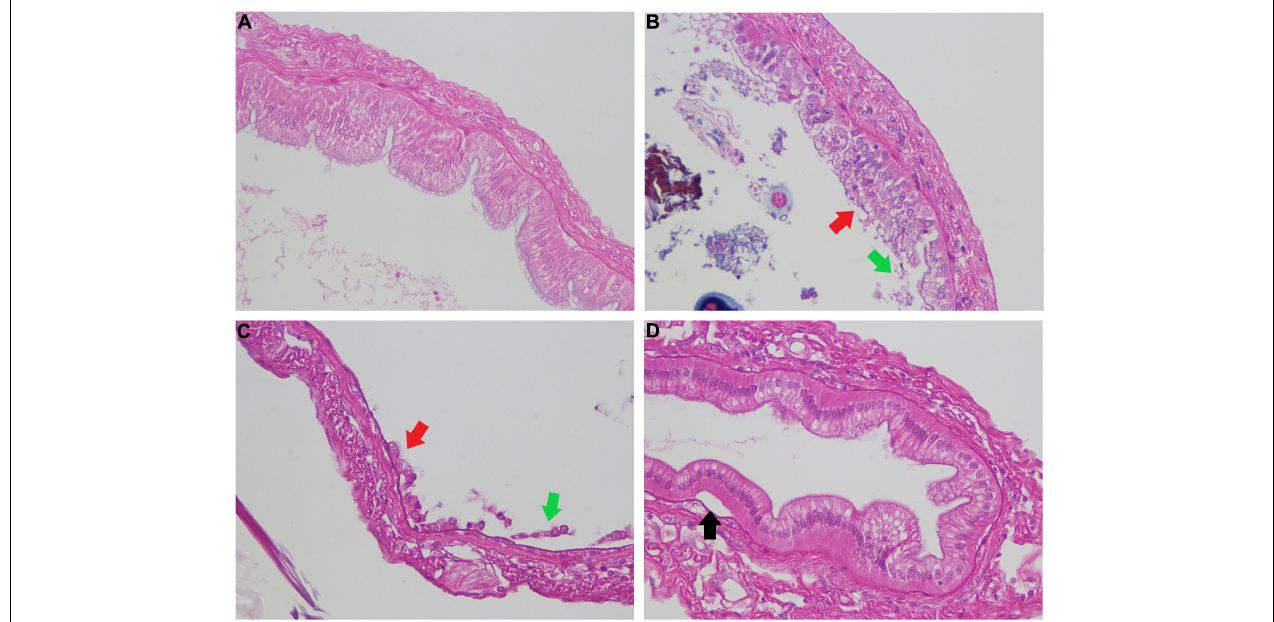
FIGURE 6 | Pathological analysis of intestinal tissue of shrimps challenged with Vibrio parahaemolyticus . Each 100 mL bacterial culture (OD 600nm 0.1) was individually poured into aquaria for bacterial bath challenge to shrimps with the final concentration of 10 5 CFU/mL. The intestine samples were performed H&E staining and imaged by microscopy. Panel (A) is the intestine of blank, panel (B) is intestine challenged with DH82, panel (C) is intestine challenged with 17SZ, panel (D) is intestine challenged with 17SZ and treated with continuous DH82. The arrows point out where the intestinal epithelial cells detach from the basement membrane (black arrows), the occurrence of basophilic hypertrophied nuclei with a reduced volume of eosinophilic cytoplasm (red arrows), and the disintegrated intestinal epithelial cells (green arrows).